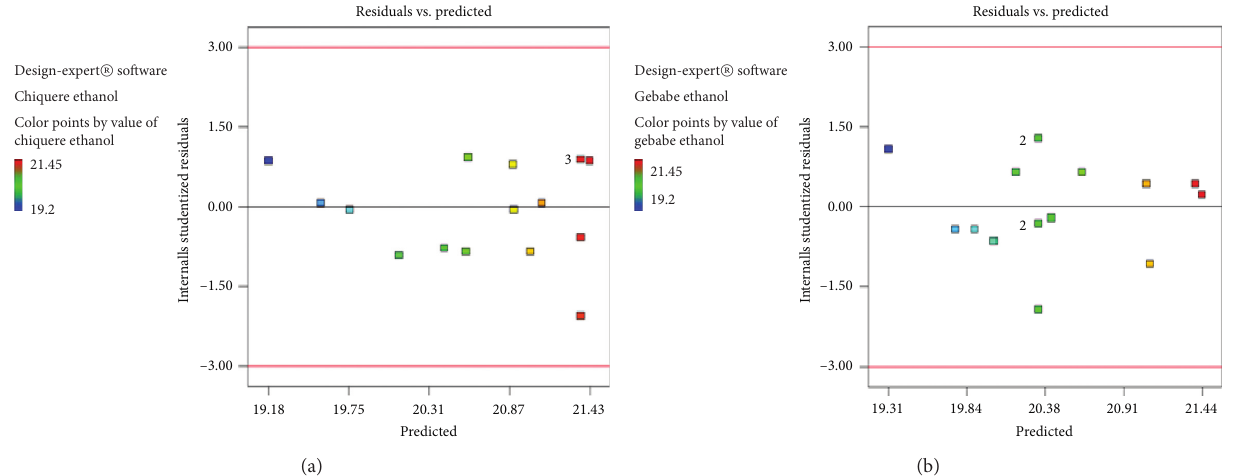
Figure 3: Plot of residuals versus model predicted values for ethanol production from Chiquere and Gebabe varieties of sweet sorghum. (a) Chiquere variety; (b) Gebabe